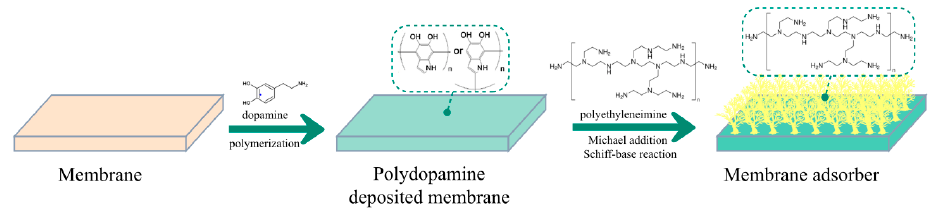
Figure 1. Schematic diagram of membrane adsorber prepared by depositing PDA layer on membrane to couple PEI.